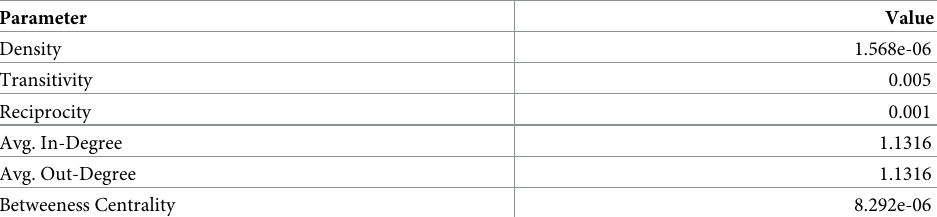
Table 6. Summary statistics of citation